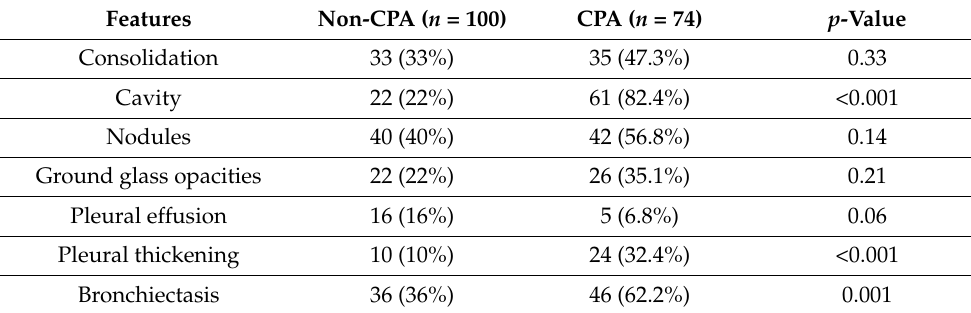
Table 2. Comparison of imaging findings (Chest radiograph & CT